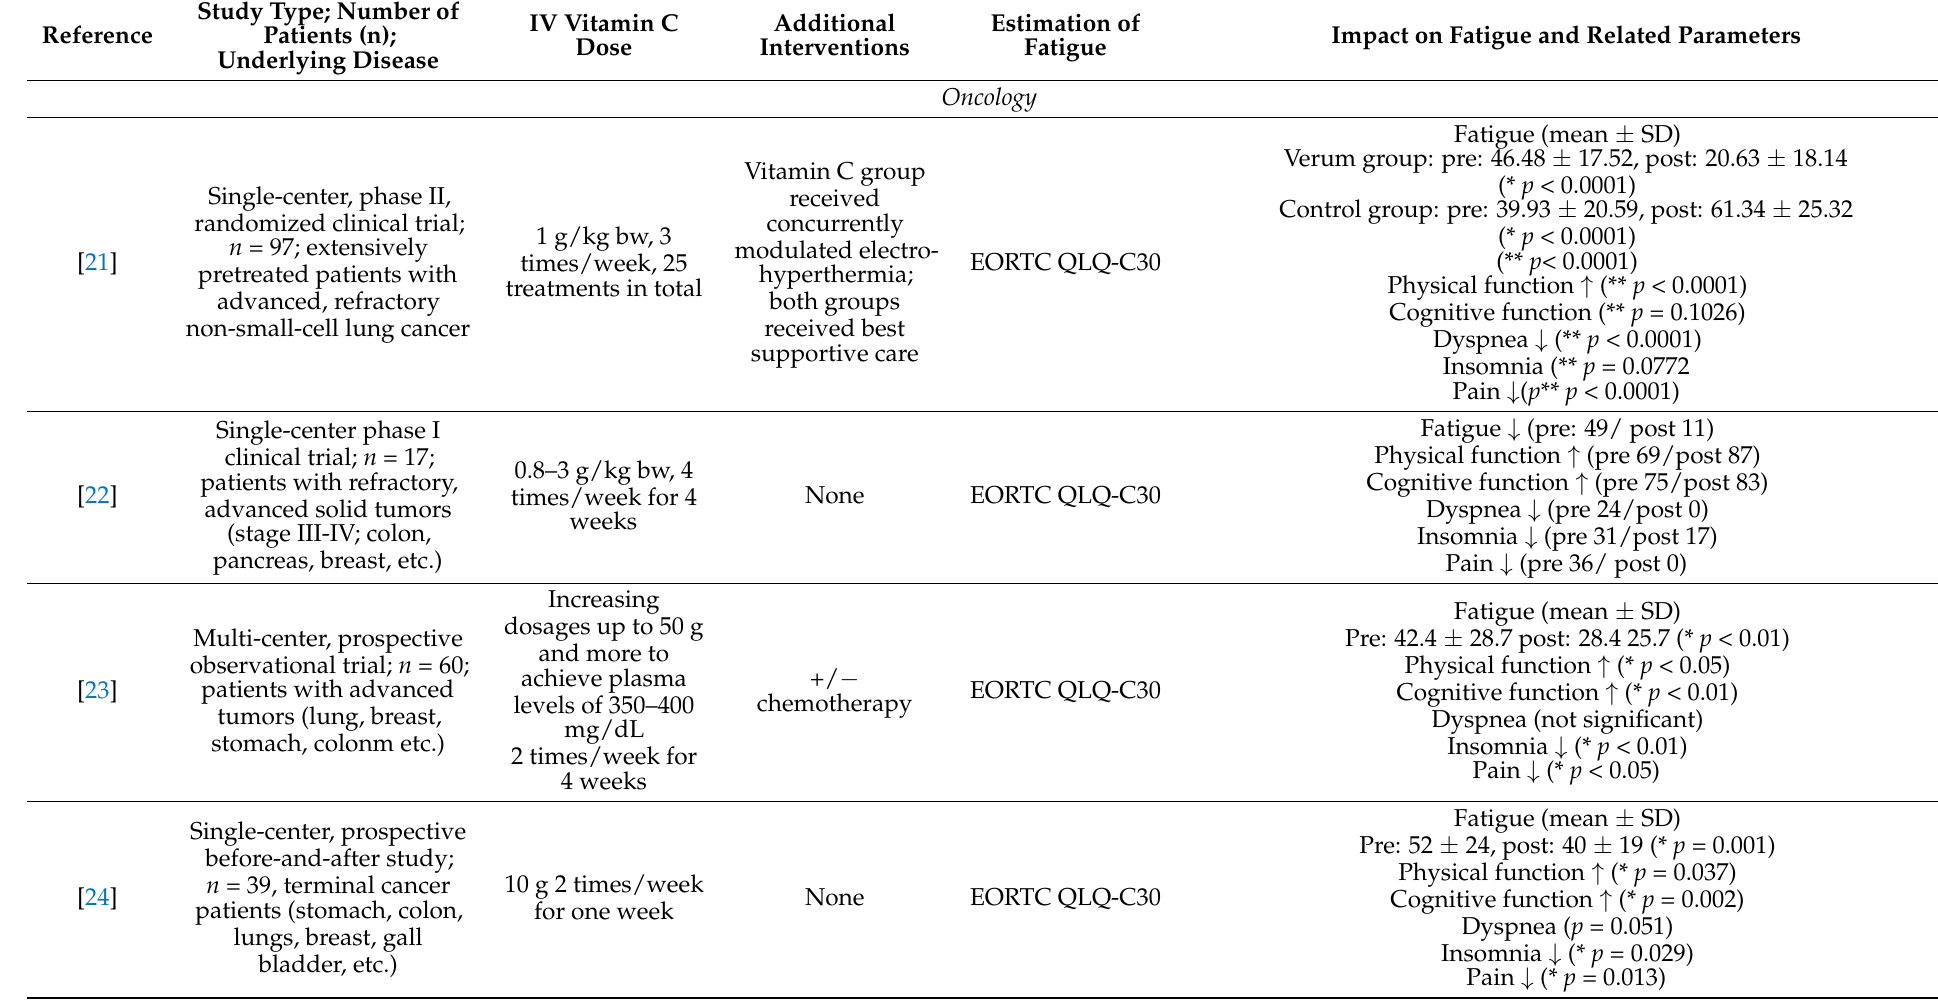
Table 1. Clinical studies investigating intravenous vitamin C in conditions with fatigue. * p -value for pre vs. post; ** p -value for verum vs. control; bw: body weight; NRS: numeric rating